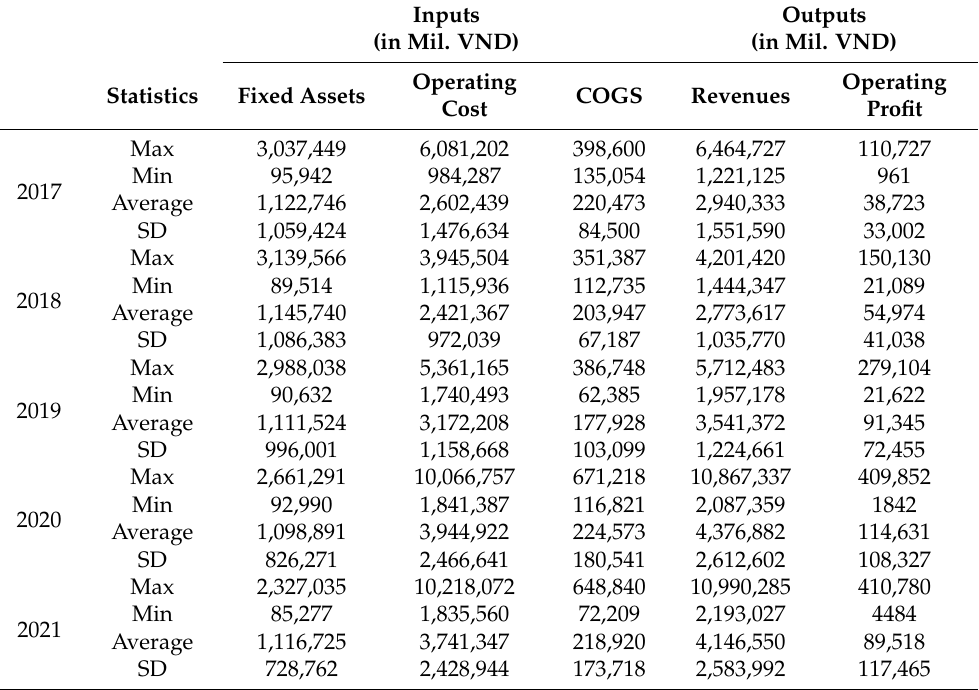
Table 3. Input and output factors of 10 coal mining projects in 2017–2021 (in Mil. VND).